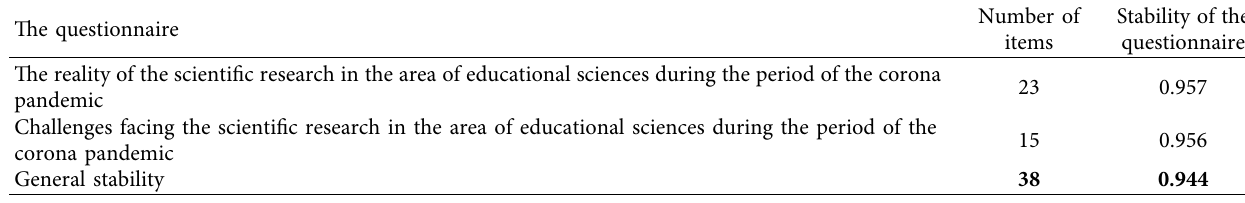
Table 5: Cronbach’s alpha coefficient to measure the stability of the study tool.